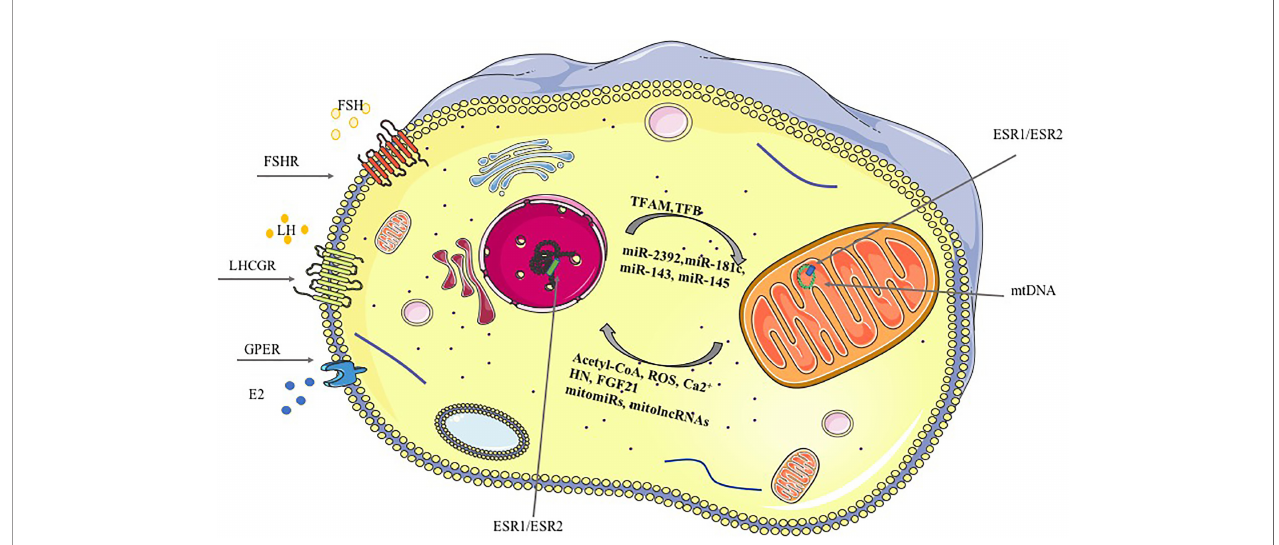
FIGURE 1 | Mitochondria-nucleus crosstalk, anterograde and retrograde signaling. Gonadotropins and ovarian hormones signaling pathways regulating mitochondrial dynamics and function are reported in the fi gure underlining the cellular comportment involved. Anterograde and retrograde signals are reported for the mitochondrion-nucleus crosstalk. Anterograde signals (nucleus to mitochondria) include: the nuclear-encoded transcription factors (TFs, TFAM and TFB that bind the mtDNA, nuclear receptors (NRs) and ncRNAs, among the others. Retrograde signals (mitochondria-nucleus) include: Ca2+, ROS, mitomiRs, mitolncRNAs, among the others